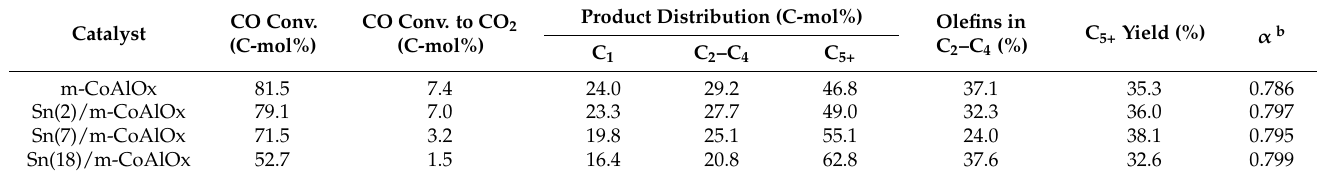
Table 2. Catalytic activity and product distribution on the Sn/m-CoAlOx catalysts a